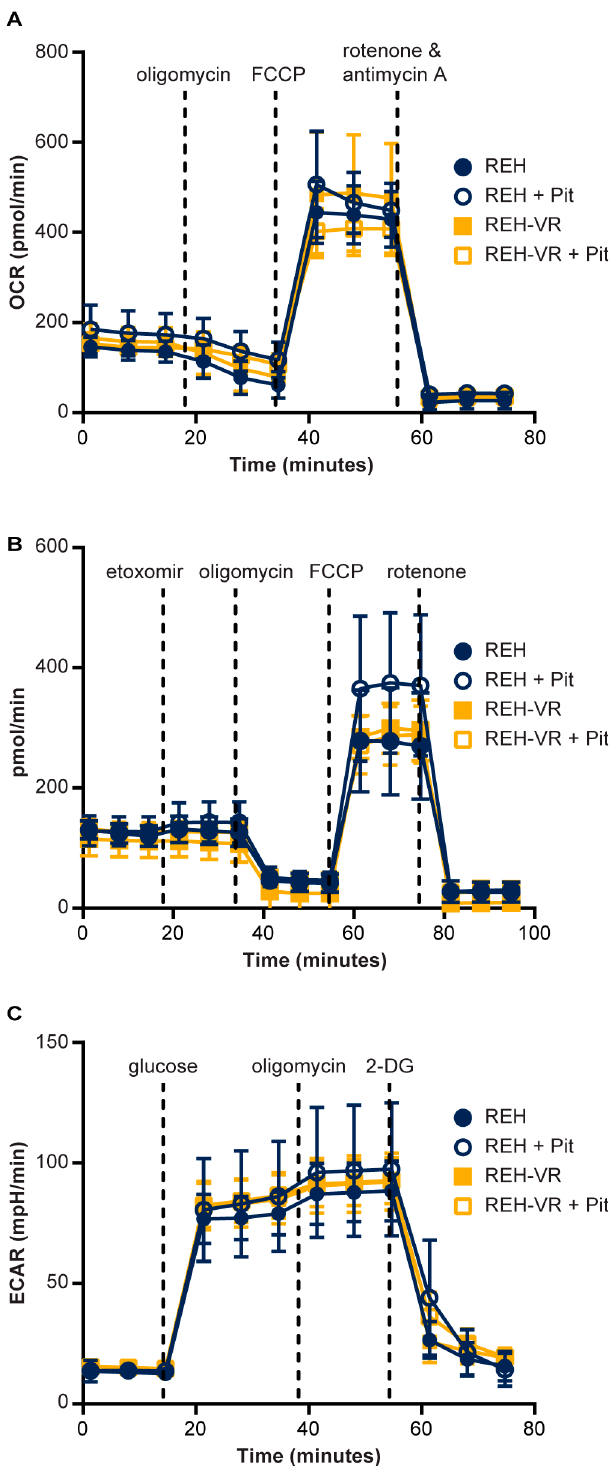
Figure 3. Pitavastatin treatment effects on mitochondrial bioenergetics. REH and REH-VR cells were treated with vehicle or 450 nM pitavastatin (Pit). Equal numbers of cells were plated in Seahorse 96-well plates. ( A ) Mitochondrial Stress Test. ( B ) Beta-oxidation assay. ( C ) Glycolysis assay. Pitavastatin did not significantly alter mitochondrial function in either cell type. Each data point represents average ± S.D., where n = 4. Abbreviations: 2-DG, 2-deoxyglucose; FCCP (carbonyl cyanide p-trifluoro methoxyphenylhydrazone); OCR (oxygen consumption rate); ECAR (extracellular acidification rate).